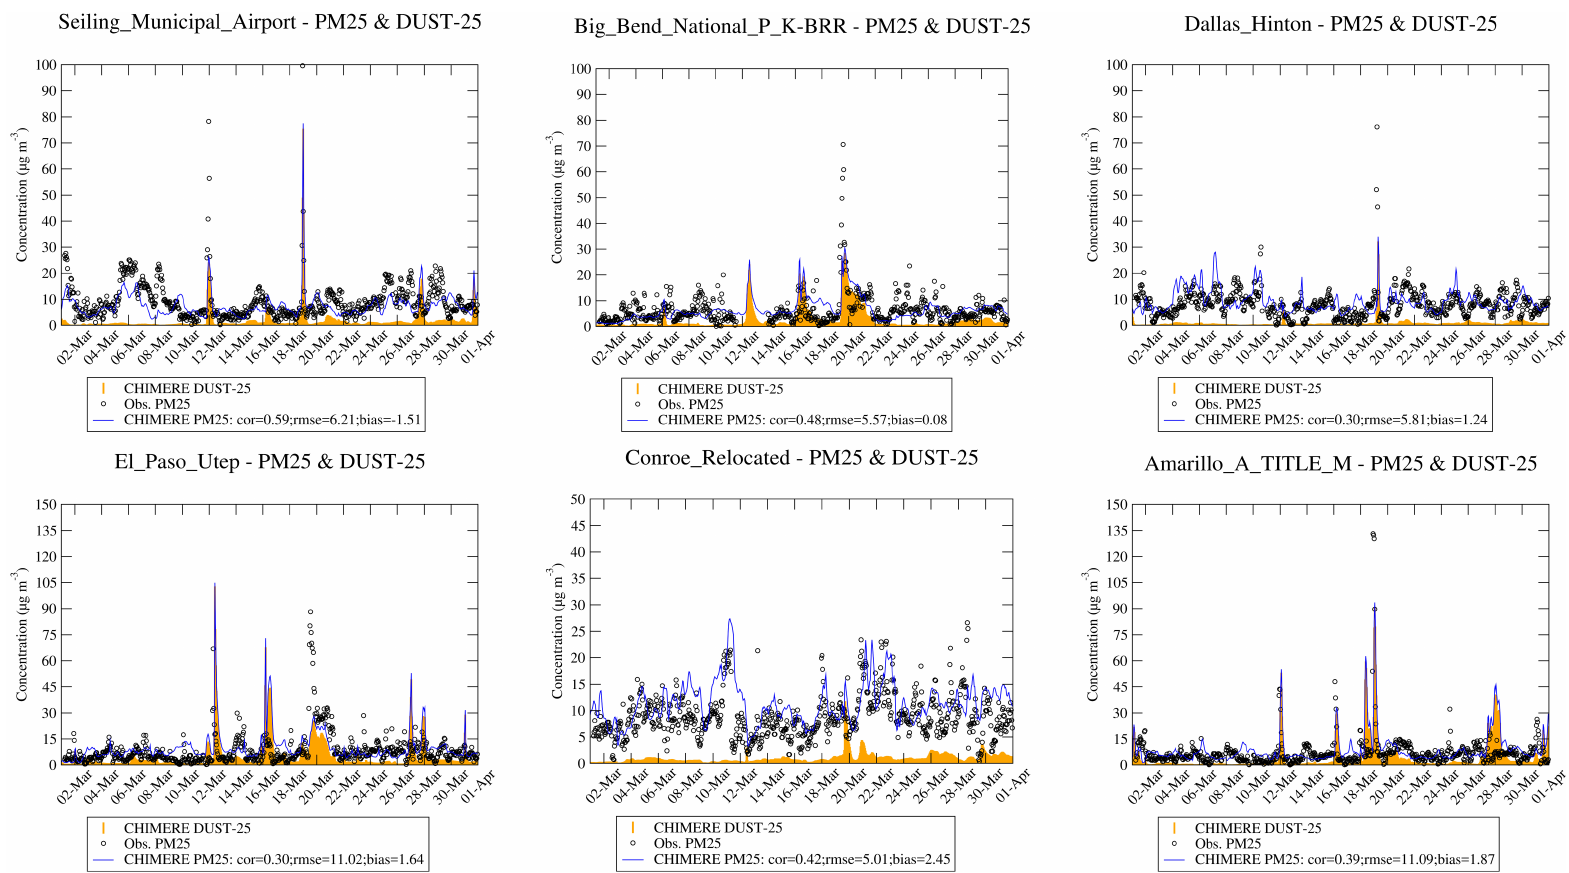
Figure 10. Hourly time series of simulated and observed PM 2.5 concentrations at six stations of the US air quality network influenced by the three dust episodes: Seiling Municipal Airport (36.16 ◦ N–98.93 ◦ W), Big Bend National Park (29.30 ◦ N–103.18 ◦ W), Dallas Hinton (32.82 ◦ N–96.86 ◦ W), El Paso Utep (31.77 ◦ N–106.50 ◦ W), Odessa Gonzales (31.87 ◦ N–102.33 ◦ W) and Amarillo A and M (35.20 ◦ N–101.91 ◦ W). The orange shaded area represents the dust concentrations simulated by CHIMERE for the corresponding PM